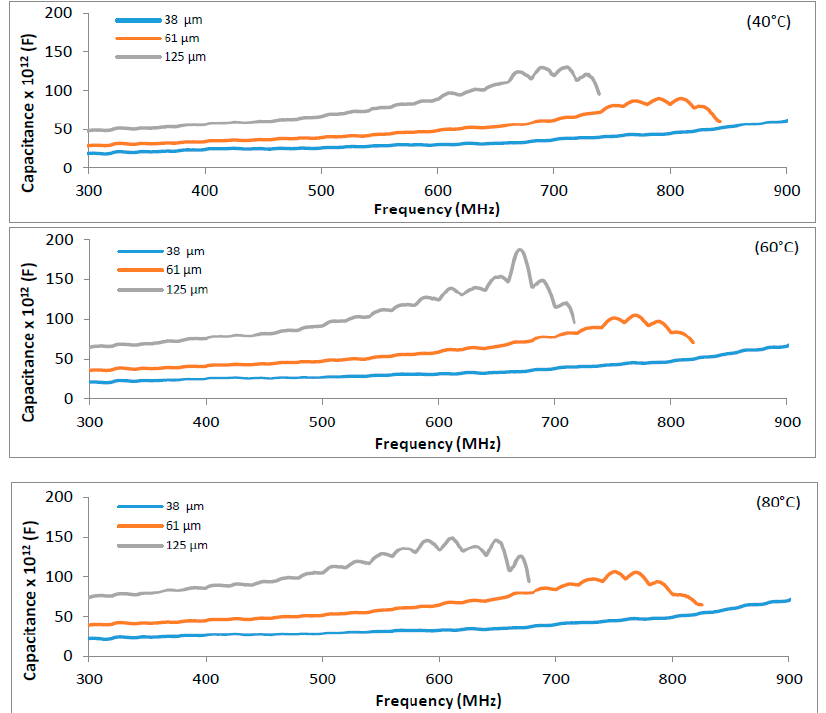
Figure 2. Influence of frequency (300–900 MHz) on the electrical capacitance of gelatin, with thickness of 38, 61, and 125 µm, for temperatures equal to 40 °C, 60 °C, and 80 °C. Experiments made in triplicate with coefficient of variation below 10%.